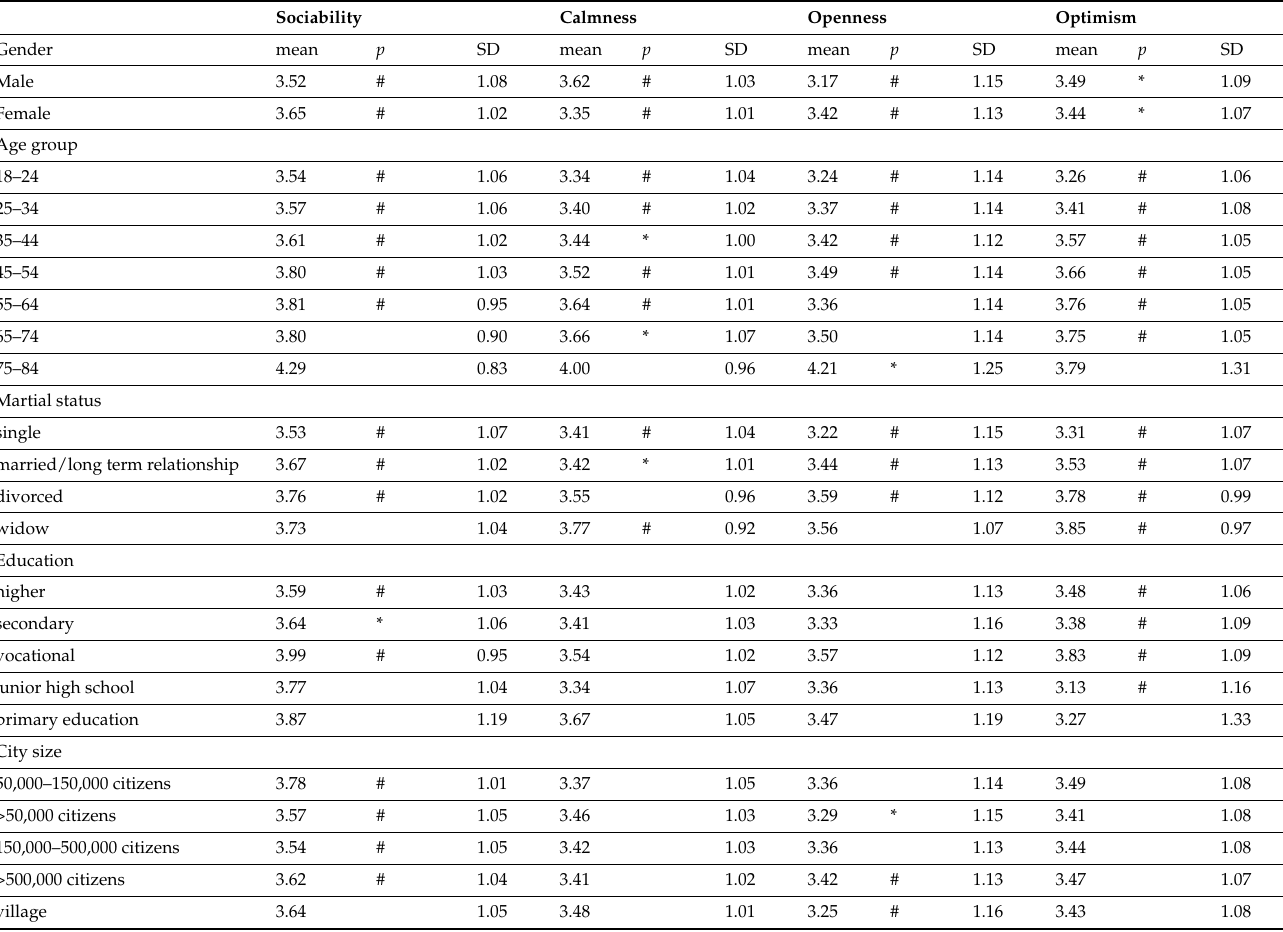
Table 2. Results of self-assessment of personality